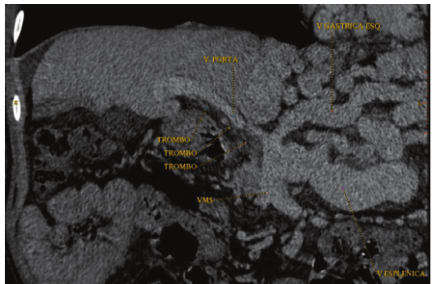
Figure 4: Preoperative computed tomography showing extensive thrombosis of portal and superior mesenteric veins and enlarged left gastric vein draining the bowel.